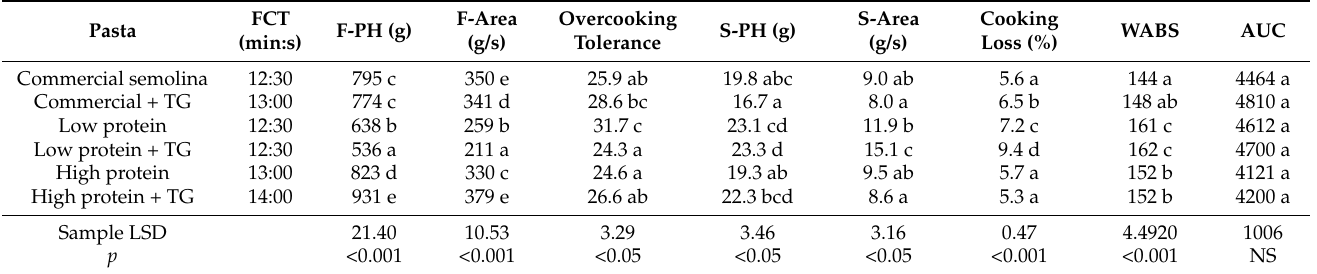
Table 4. Effect of including transglutaminase (TG) at 0.5% ( w / w ) in the pasta formulation at three different protein levels on pasta technological attributes and the extent of starch